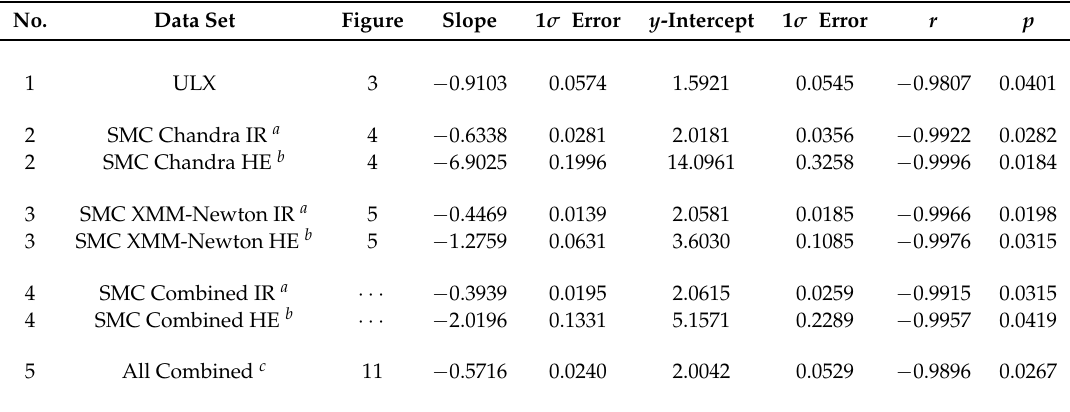
Table 3. Least-squares fits to X-ray flux/luminosity